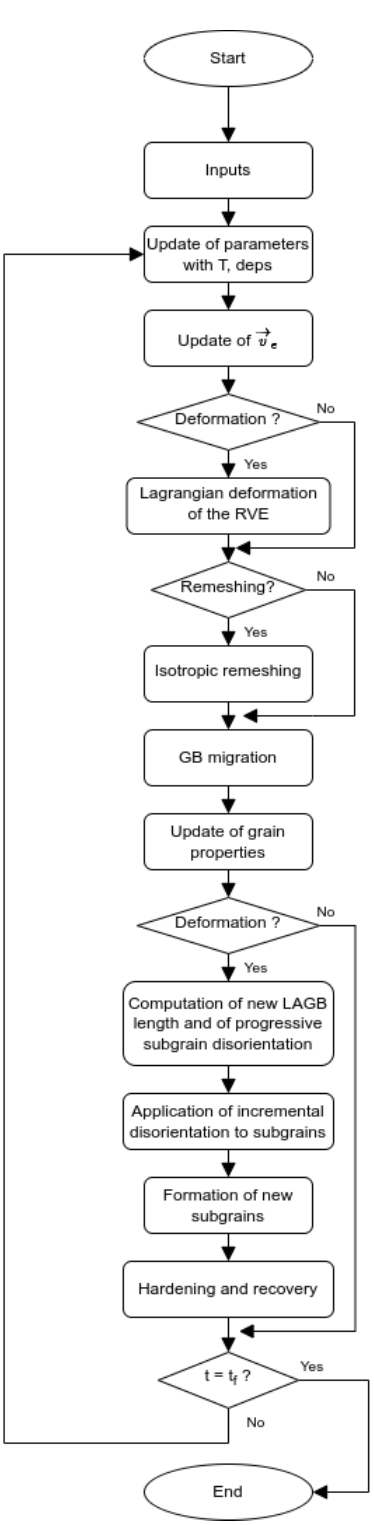
Figure A2. Algorithm describing the numerical steps to simulate microstructure evolutions during hot deformation and holding at